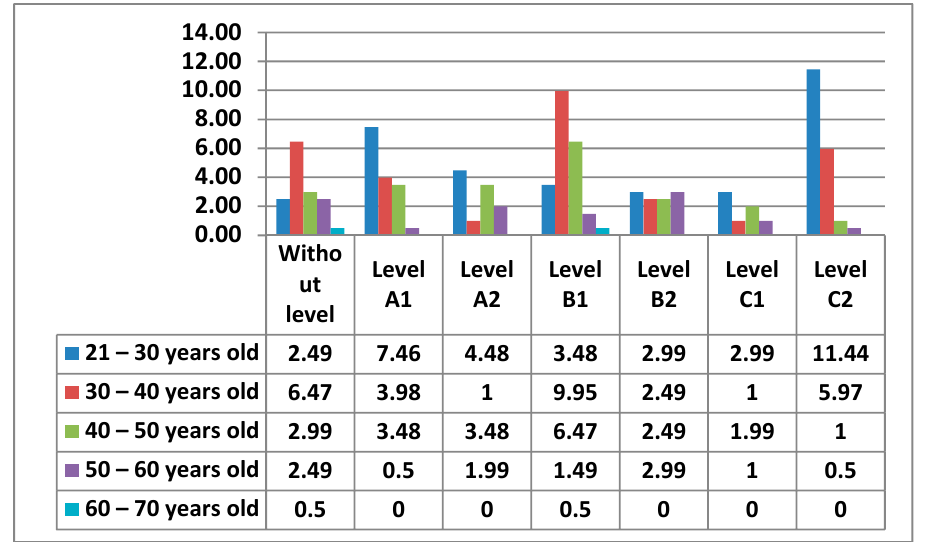
Figure 23. Digital competence in teachers by age in Area 4.